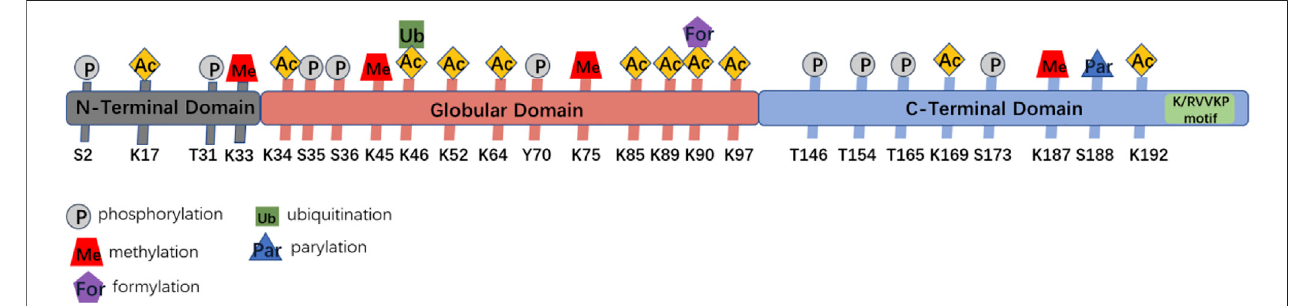
FIGURE 2 | The scheme of functional domains and post-translational modi fi cations sites of H1.2. H1.2 binds Bak via the C-terminal domain (V203) of K/ RVVKP motif.